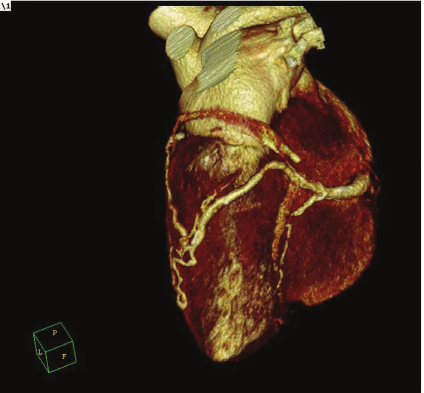
Figure 2: Multislice computed tomography. Volume rendering image shows that right coronary artery preceded in its regular pathway and gave branches to the left coronary system and then terminated with a fistula into the left ventricle.